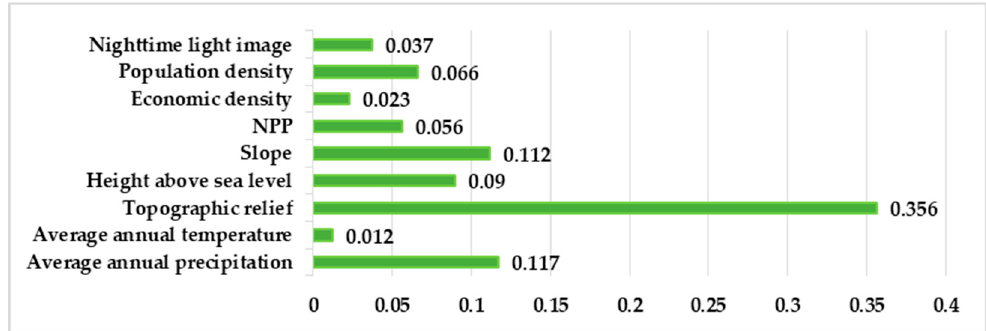
Figure 10. The absolute value of the correlation